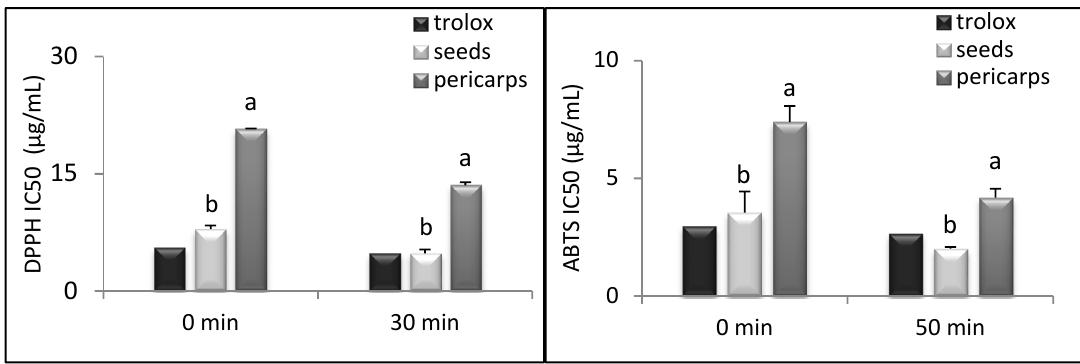
Figure 1. Scavenging of 50% of DPPH and ABTS radical by Trolox and ethanolic extracts from di ff erent fruit parts (seeds and pericarps) of exhausted myrtle berries (EMB) at di ff erent time points (0 and 30 min). Data were expressed as means ± SD of three independent experiments. Di ff erent letters (a,b) indicate significant di ff erences ( p < 0.01) between seeds and pericarps of EMB at each time point.